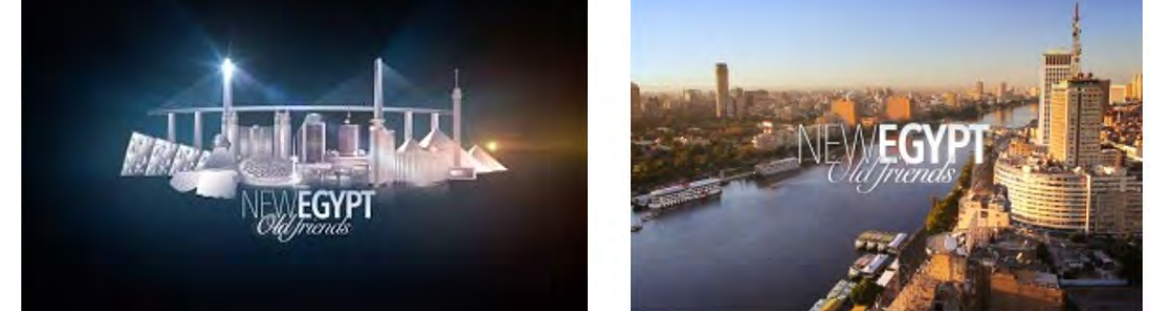
Figure 10. complicated logo used in the campaign (New Egypt Old Friends, 2016)